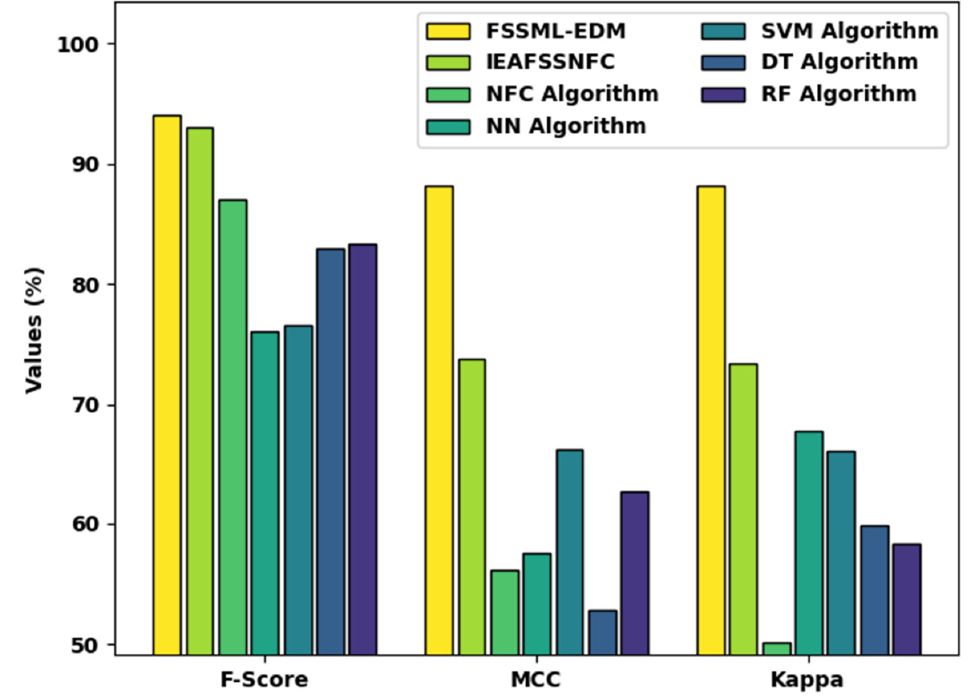
Figure 12. 𝐹 (cid:3046)(cid:3030)(cid:3042)(cid:3045)(cid:3032) , 𝑀𝐶𝐶 , and 𝑘𝑎𝑝𝑝𝑎 analysis of FSSML-EDM